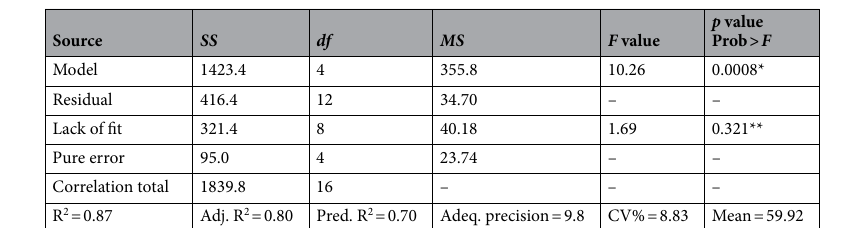
Correlation total 1839.8 16 – – – R 2 = Table 2. Analysis of variance (ANOVA) of the response surface quadratic model of the biosorption of Cu 2+ ions onto R. damascena . Df degree of freedom, SS squares sum, MS mean sum of squares, CV Coefficient of variation. *Significant at p ˂ 0.05. **Not significant at p > 0.05.